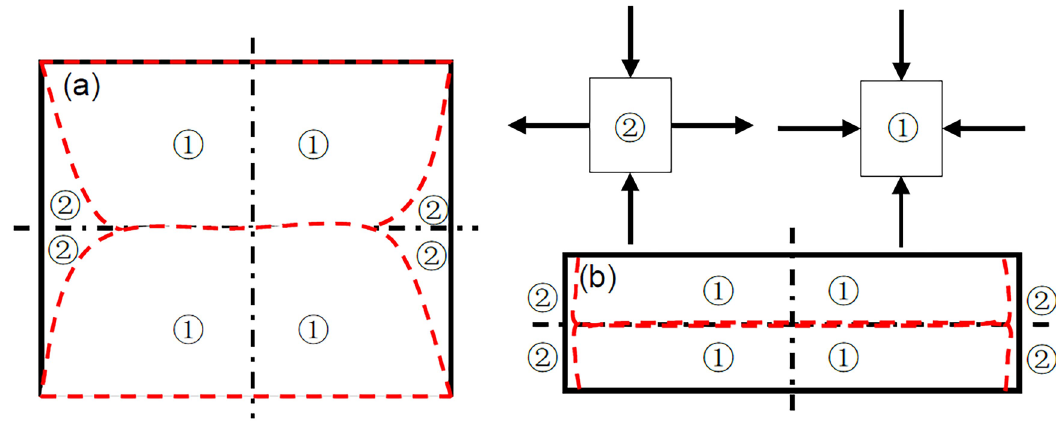
Figure 8. Stress states of ( a ) thick interlayer and ( b ) thin